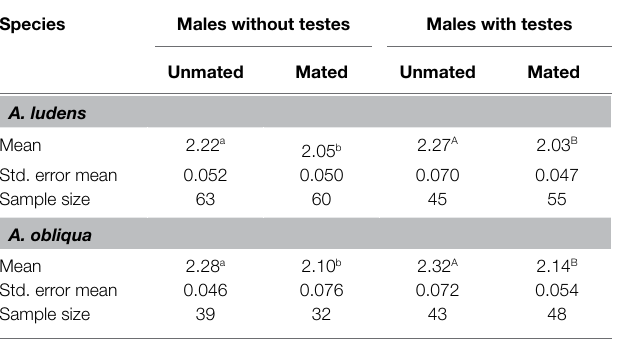
TABLE 1 | Accessory gland size (mm 2 ) of unmated and mated A. ludens and A. obliqua males with and without testes. Species